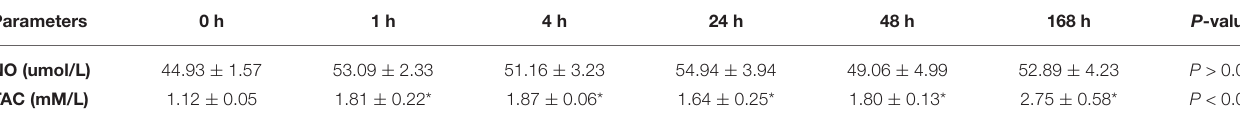
TABLE 3 | Effects of LC administration on serum NO and TAC concentrations of the heat-stressed rams at 1, 4, 24, 48, and 168h after treatment vs. 0h. Parameters 0 h 1